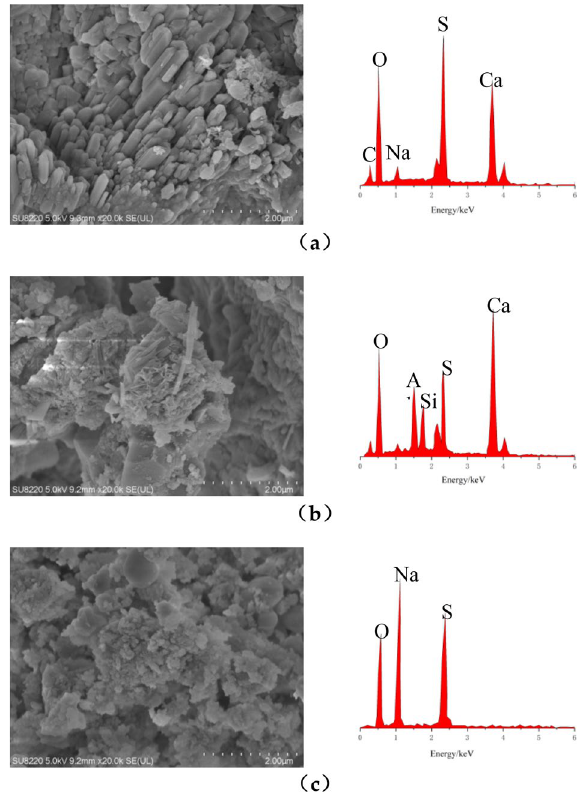
Figure 9. EDS analysis: (a) gypsum (calcium sulfate); (b) alum; (c) mirabilite (sodium sulfate crystal).